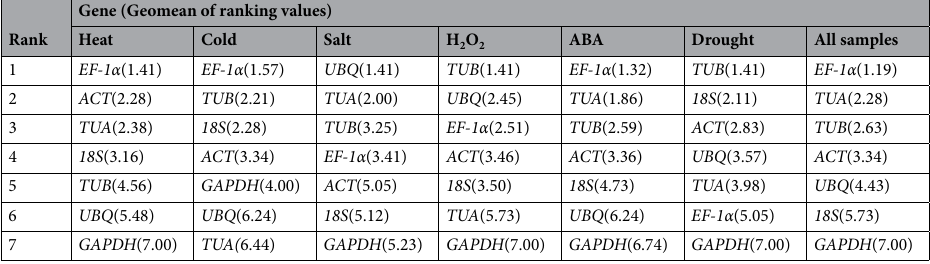
Table 4. Comprehensive ranking of